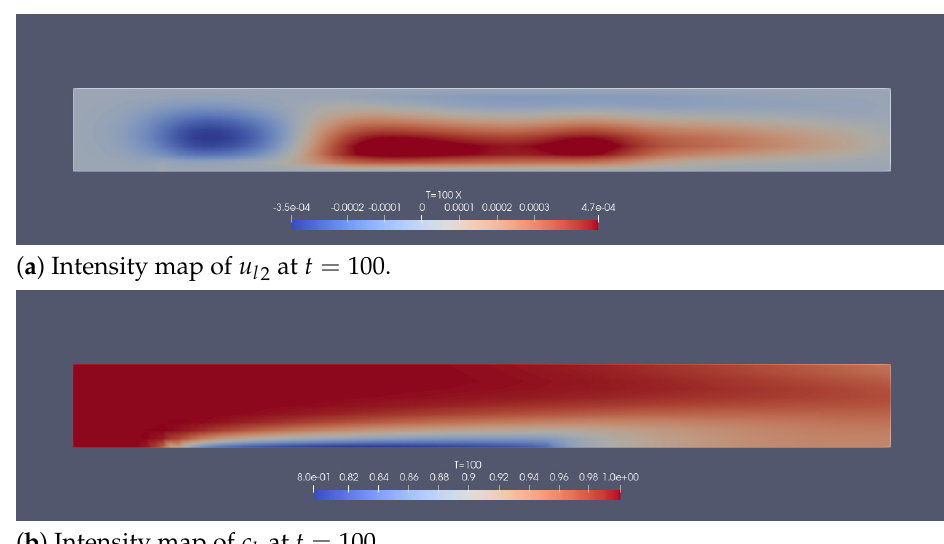
Figure 16. For Section 5.2: Intensity maps of u l 2 and c k at t = 100.